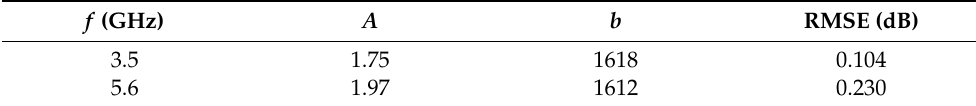
Table 6. Path-loss model parameters at 3.5 GHz and 5.6 GHz bands.